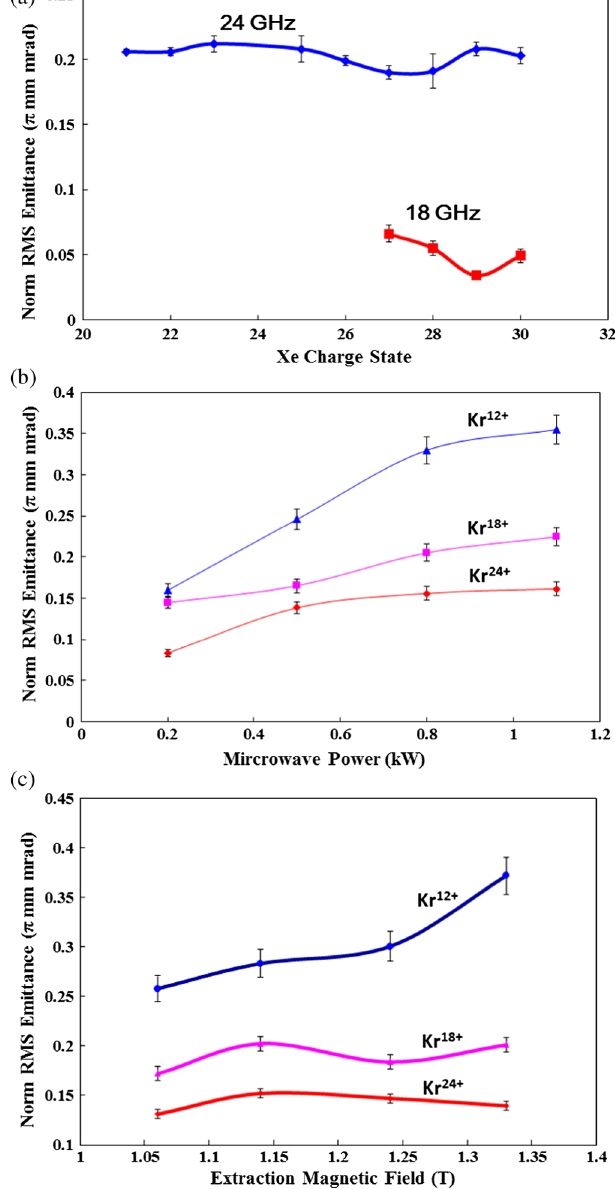
FIG. 23. SECRAL beam emittance study. (a) Xenon beam emittance measured at low microwave power of 24 and 18 GHz. (b) Dependences of normalized rms emittance on 18 GHz microwave power measured at SECRAL. (c) Dependences of normalized rms emittance on the extraction peak field at 18 GHz